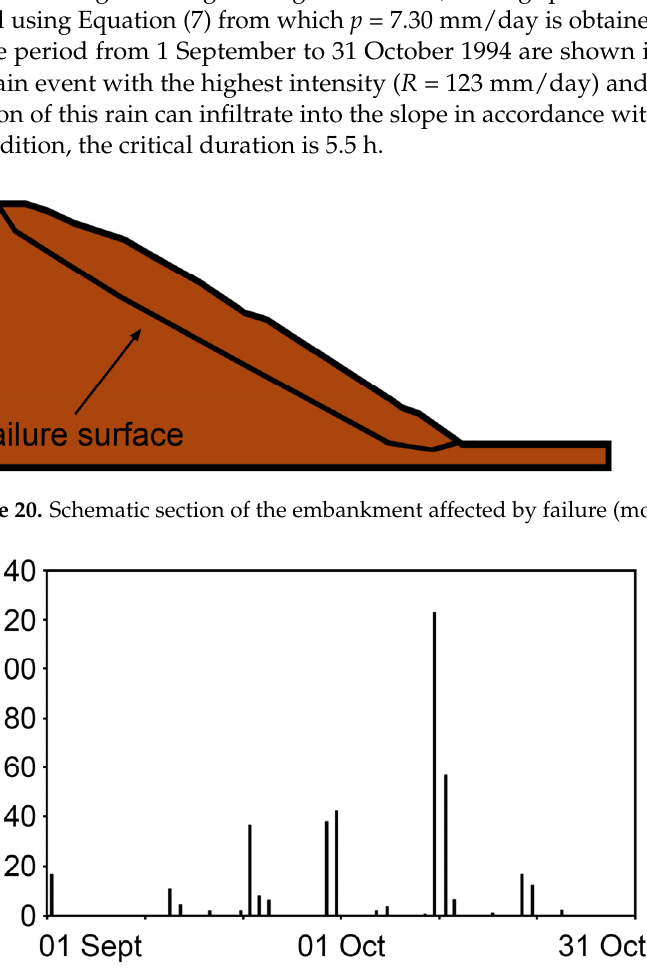
Table 4. Soil properties of the embankment (data from [54,55]).